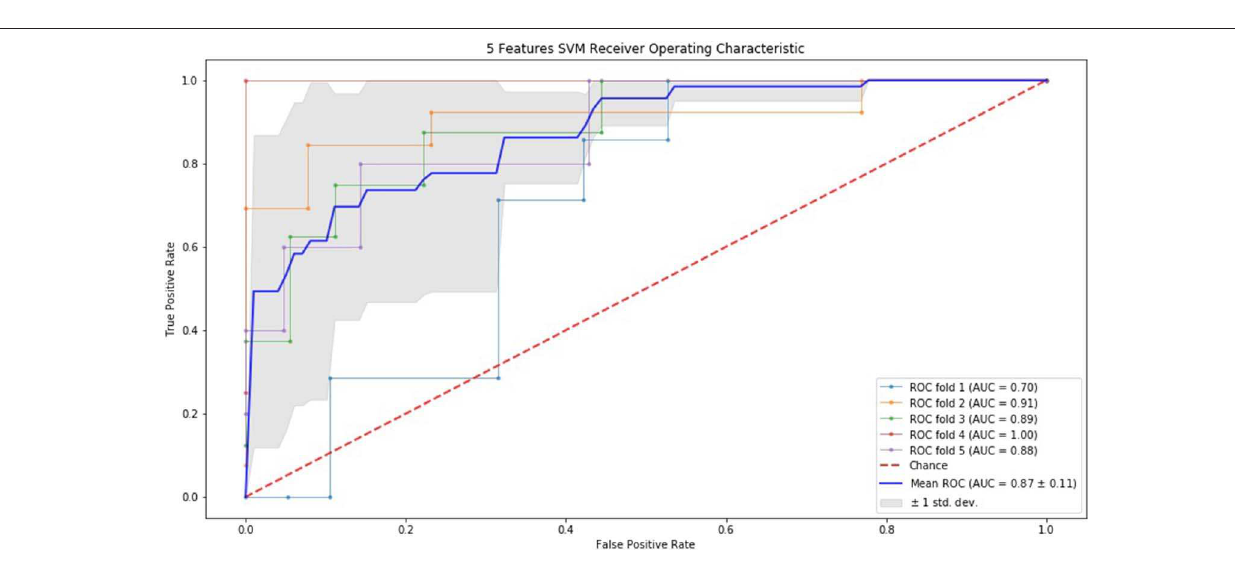
FIGURE 2 | ROC of 5-fold cross validation results of SVM. The mean AUC of 5 feature model was 0.87 ±